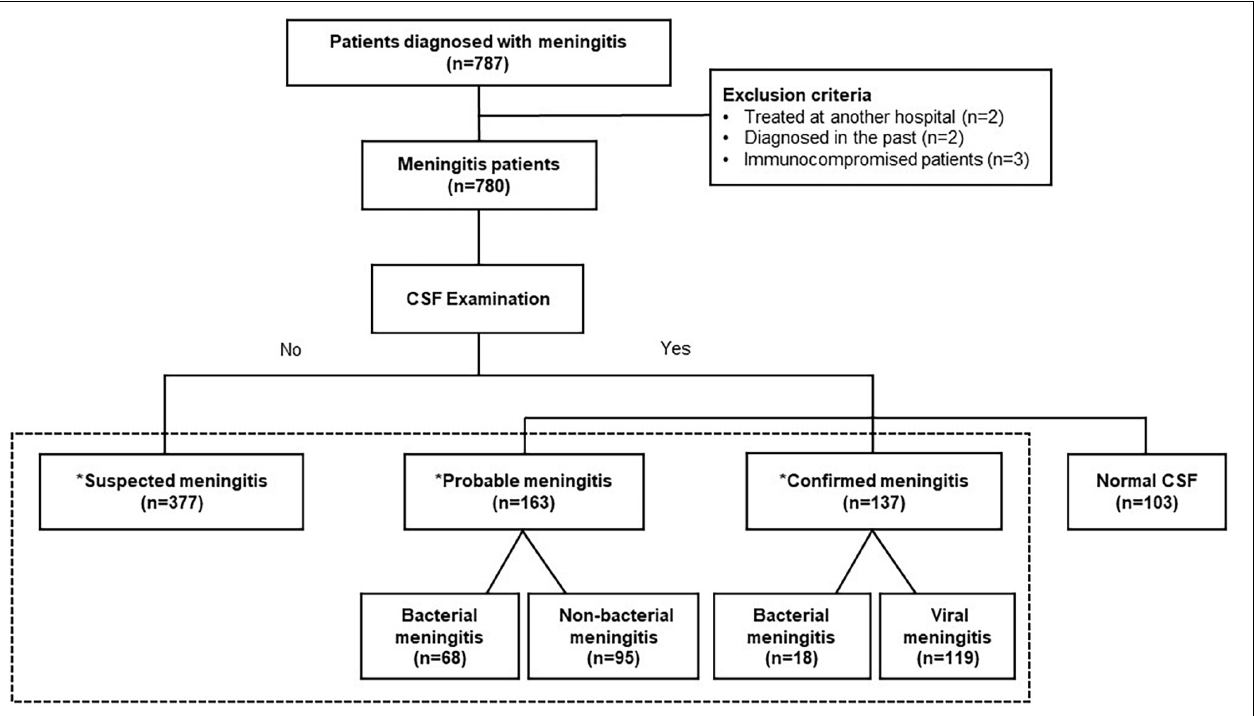
FIGURE 1 | Flowchart of the study population. *Classified by reference to the WHO’s IB-VPD (invasive bacterial vaccine preventable diseases) surveillance network’s meningitis definition criteria. CSF, cerebrospinal fluid.